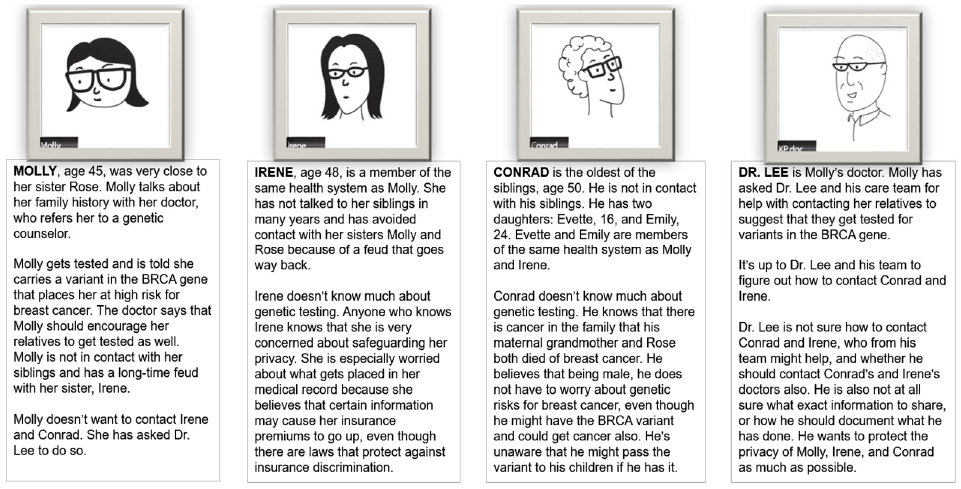
Figure 1. Fictitious family and scenario used for discussion with participants during focus groups and interviews.